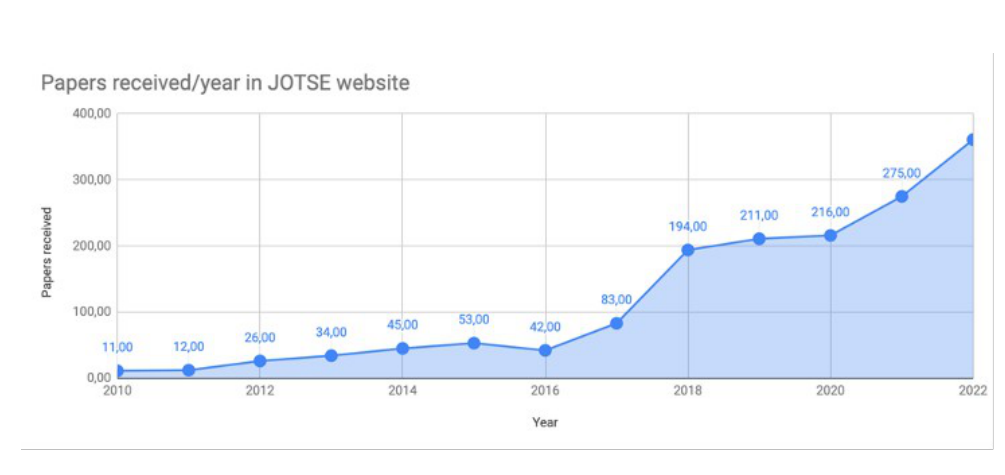
Figure 1. JOTSE's evolution